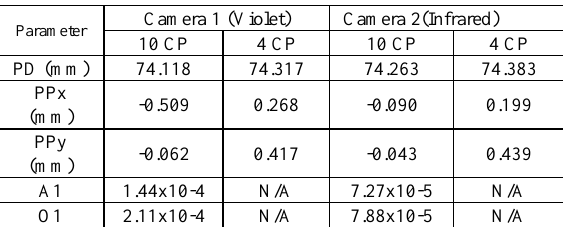
Table 3. Estimated camera calibration parameters for both violet and infrared image sets.